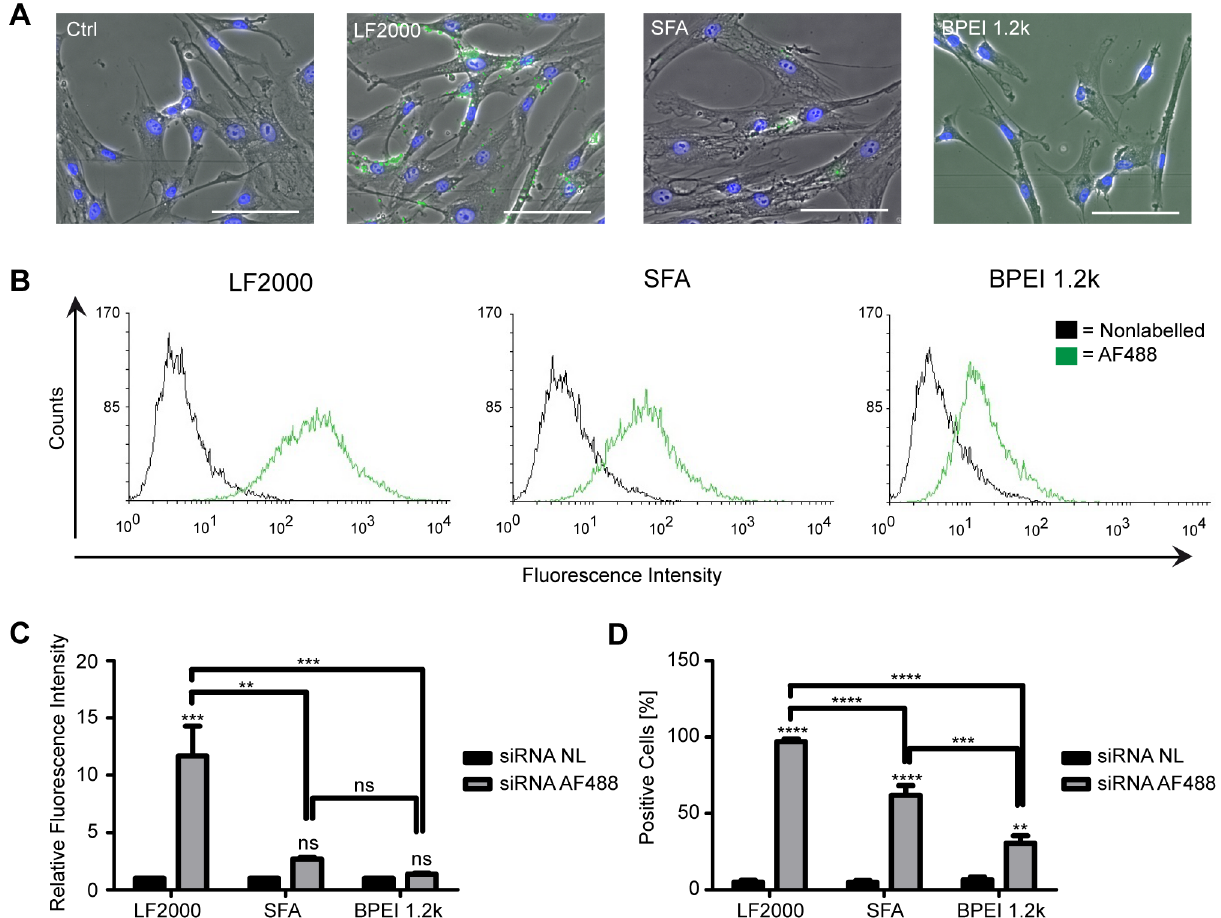
Figure 1. Delivery of siRNA into SGBS preadipocytes. Cells were transfected with a non-labelled and an Alexa Fluor 488 (green) labelled, nonspecific siRNA using Lipofectamine 2000 (LF2000), ScreenFect A (SFA) and BPEI 1.2 k as delivery agents. Uptake of the labelled siRNA was assayed 48 hours post-transfection with fluorescence microscopy and flow cytometry. Fluorescent overlay micrographs (A) of paraformaldehyde-fixed cells taken with a 20x objective. Nuclei were counterstained with DAPI (blue). Scale bars are 100 m m. Pictures from one representative experiment out of two performed are shown. Histogram overlays (B), relative fluorescence intensities (C) and transfection efficiencies (D) from the flow cytometric analysis of the siRNA AF488 transfected cells. Data are expressed as mean and SEM of three independent triplicate experiments. ***p , 0.0005 LF2000 nonlabelled vs. labelled, **p , 0.0021 LF2000 vs. SFA, ***p , 0.0007 LF2000 vs. BPEI in (C), ****p , 0.0001 LF2000 and SFA nonlabelled vs. labelled, **p , 0.0015 BPEI nonlabelled vs. labelled, ****p , 0.0001 LF2000 vs. SFA and LF2000 vs. BPEI and ***p , 0.0002 SFA vs. BPEI in